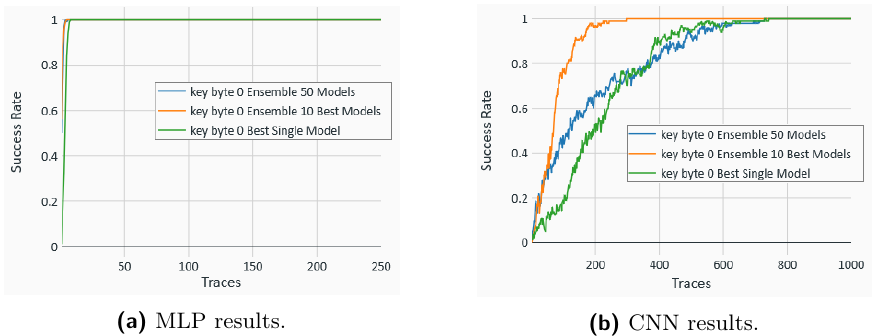
Figure 9: Success rate for DPAv4 for the Hamming weight leakage model.